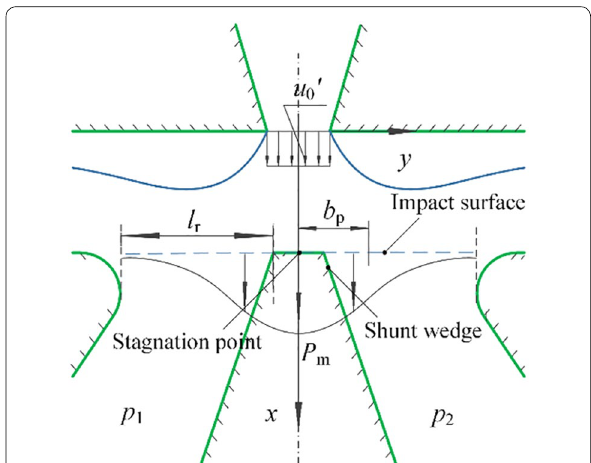
Figure 7 Second jet pattern